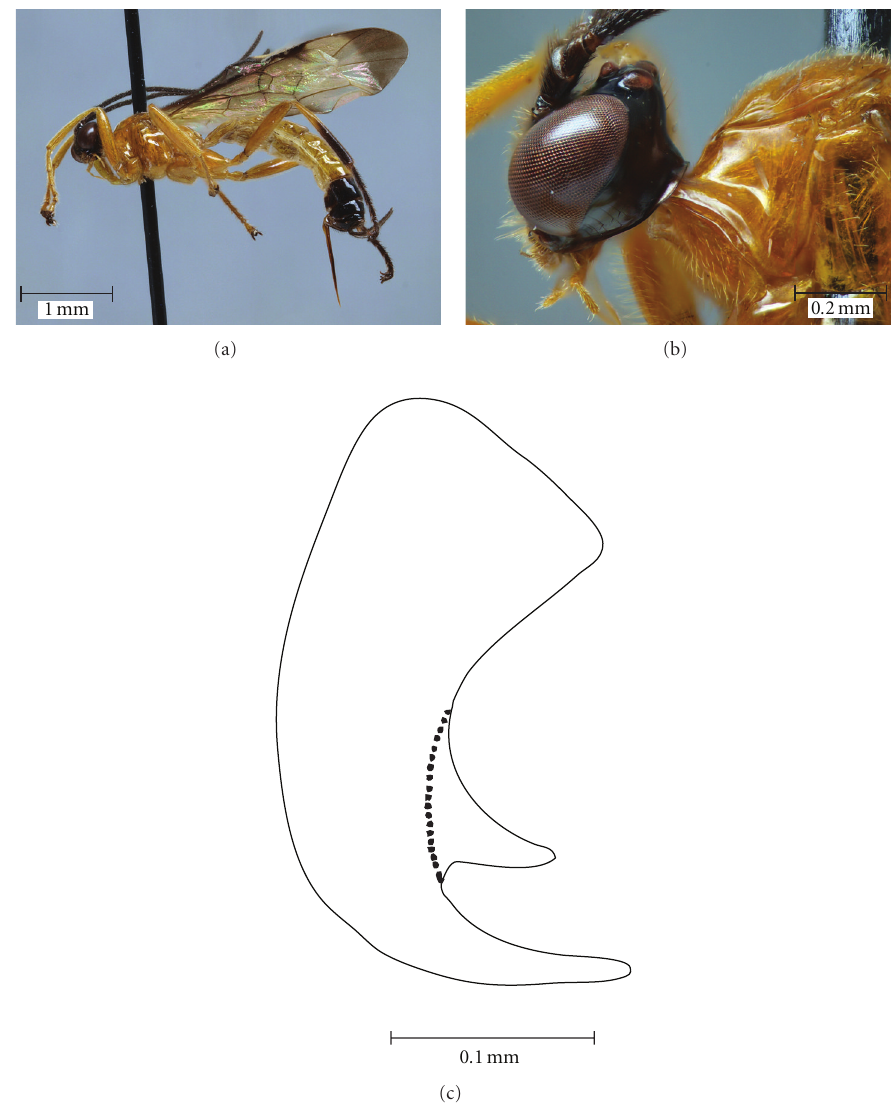
Head and antenna black, mouthparts and distal edge of clypeus orange. Mesosoma entirely orange. Metasoma orange, with tergites VI + and ovipositor sheath black. Anterior two pairs of legs orange; hind legs orange with distal 0.6 of tibia and entire tarsus black. Wings very faintly yellowish, the fore wing with apex and area adjacent to pterostigma clearly infumate; pterostigma black. Male.